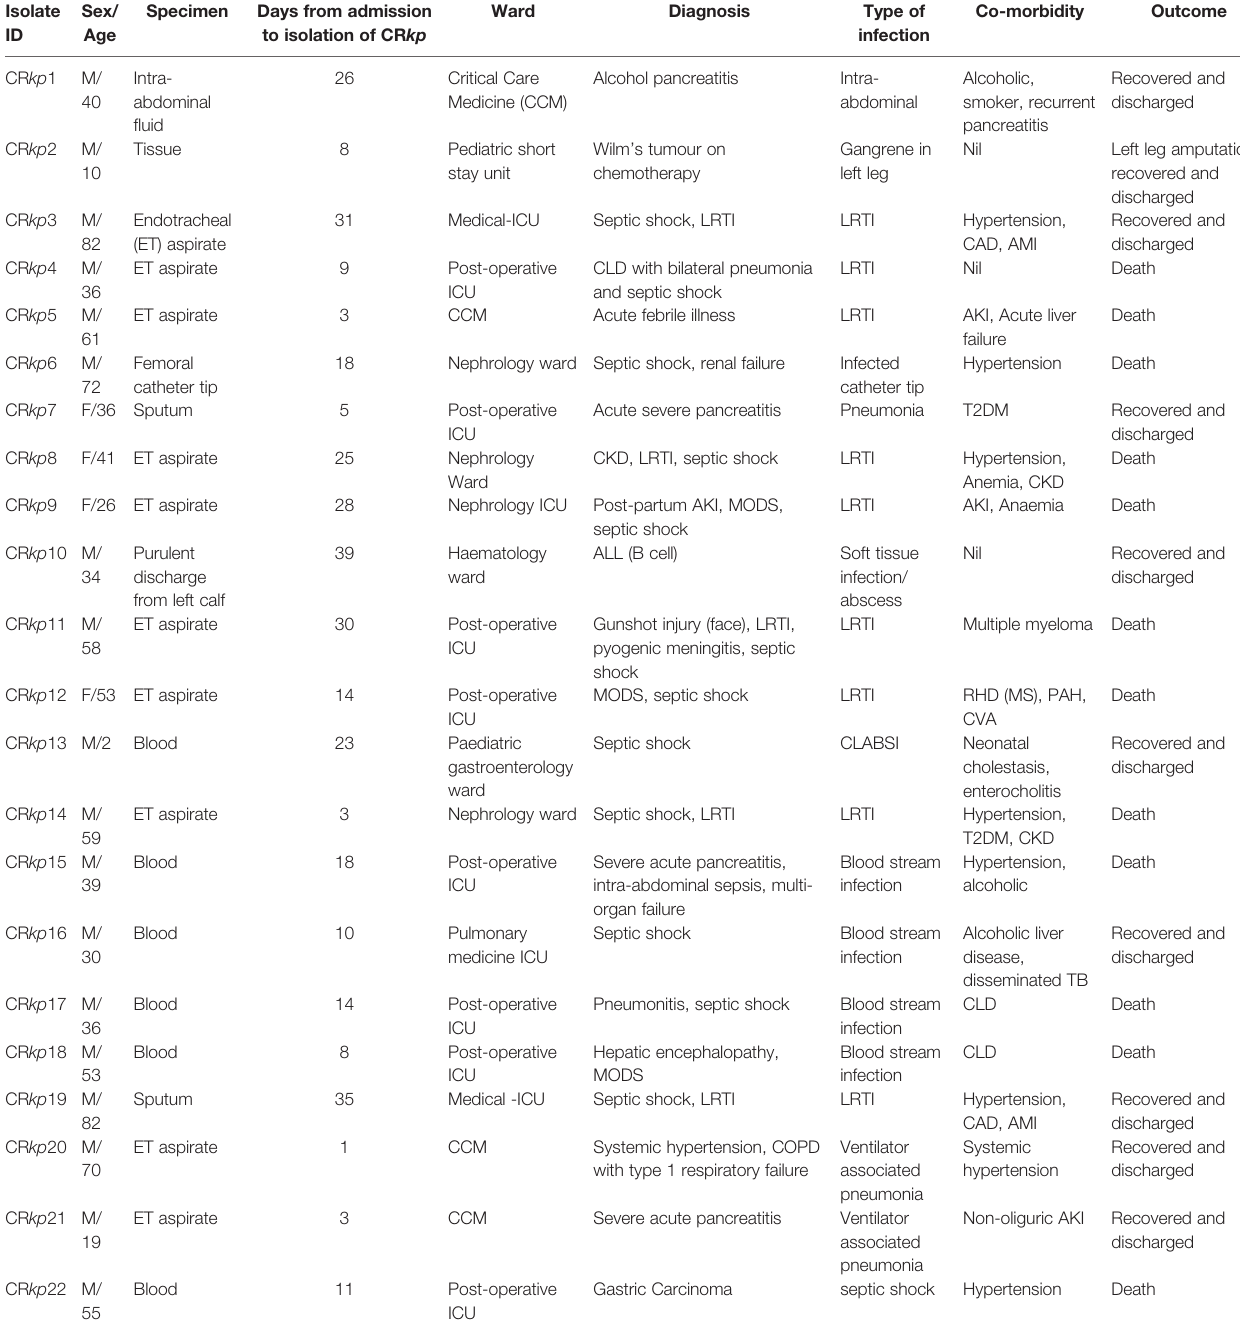
TABLE 1 | Demographic and clinical features of patients infected with colistin resistant Klebsiella pneumoniae . Isolate Sex/ ID